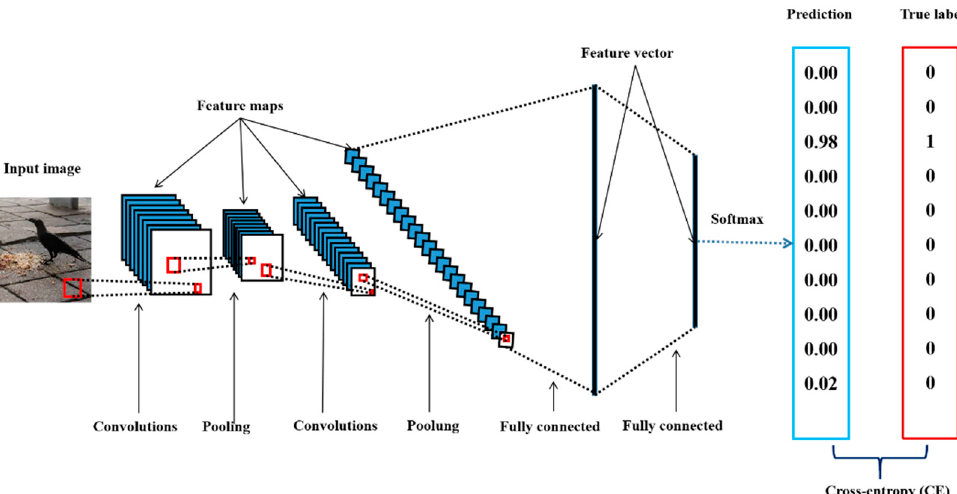
Figure 2. Overview of the deep convolutional neural network (DCNN) architecture. A DCNN consists of several layers (including but not limited to a convolutional layer, pooling layer, and fully connected layer) of abstraction that tend to gradually convert raw data into more abstract concepts [42]. For example, the raw pixels of the input data are first transformed into low-level features, then more complex features, and then high-level features until a final prediction is made by the final fully connected layer, which employs a softmax function that can return a vector of the same size as the number of categories to be identified. Each element of the vector is a value between 0 and 1, with higher values signalling higher confidence of the model in the predicted category of the input